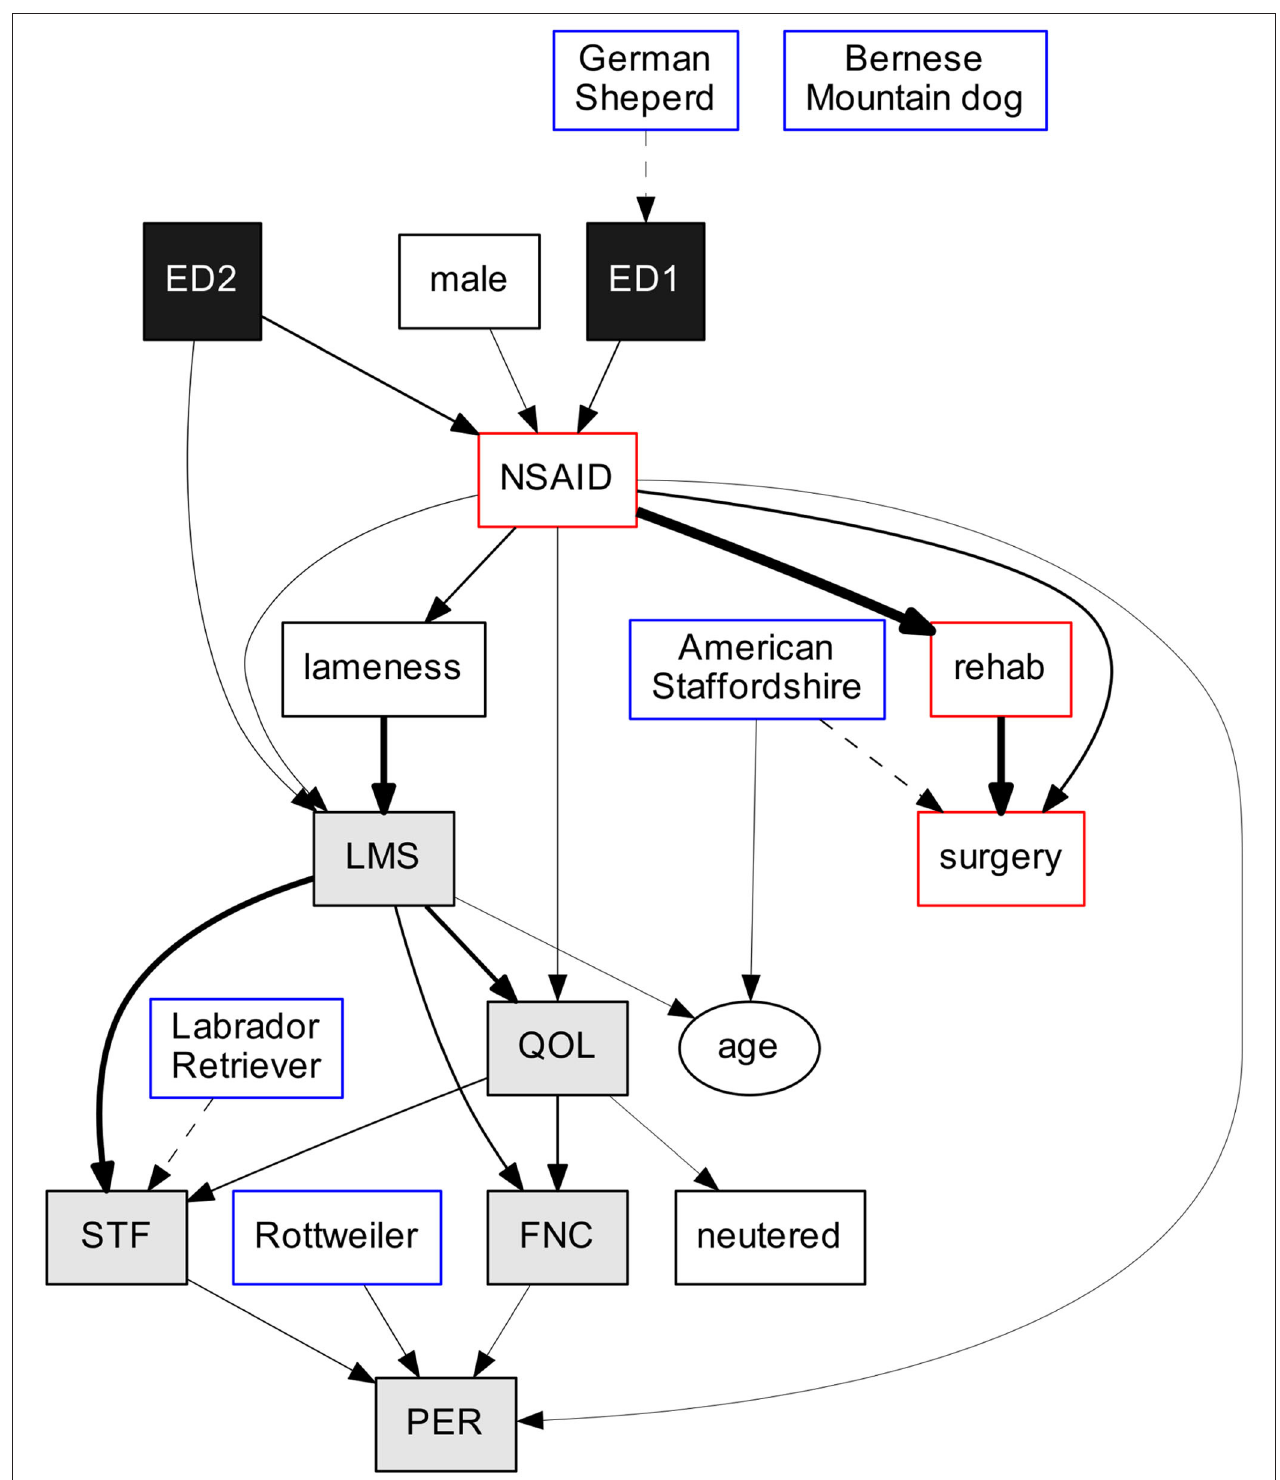
FIGURE 1 | Outcome of additive Bayesian network model. Rectangles indicate binary variables, and ovals, continuous ones. Solid arrows indicate positive association, while dashed arrows, negative association. Arrow thickness reflects the link strength. Variables are color-coded according to their classification: black for elbow dysplasia (ED) grade, gray for Canine Orthopedic Index (COI), white for demography and lameness, red-contoured for treatment type, and blue-contoured for breed.